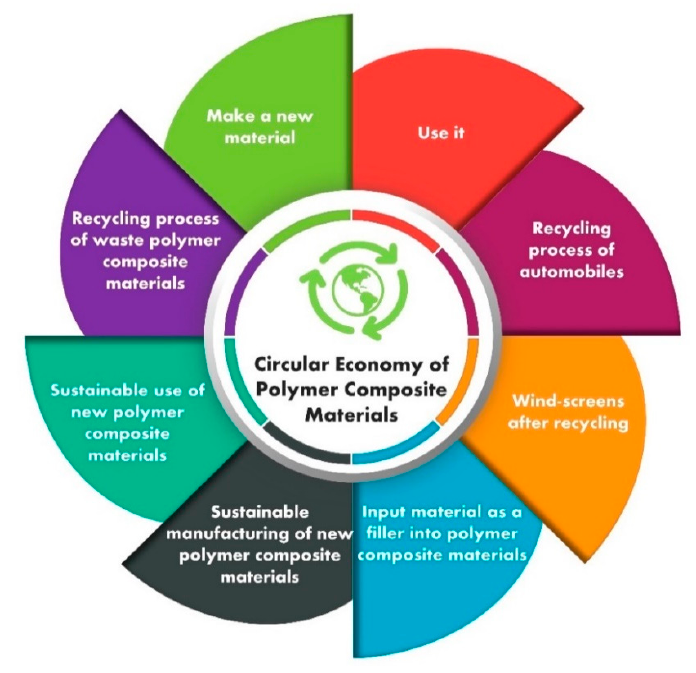
Figure 2. Circular economy concept for a polymer composite material.